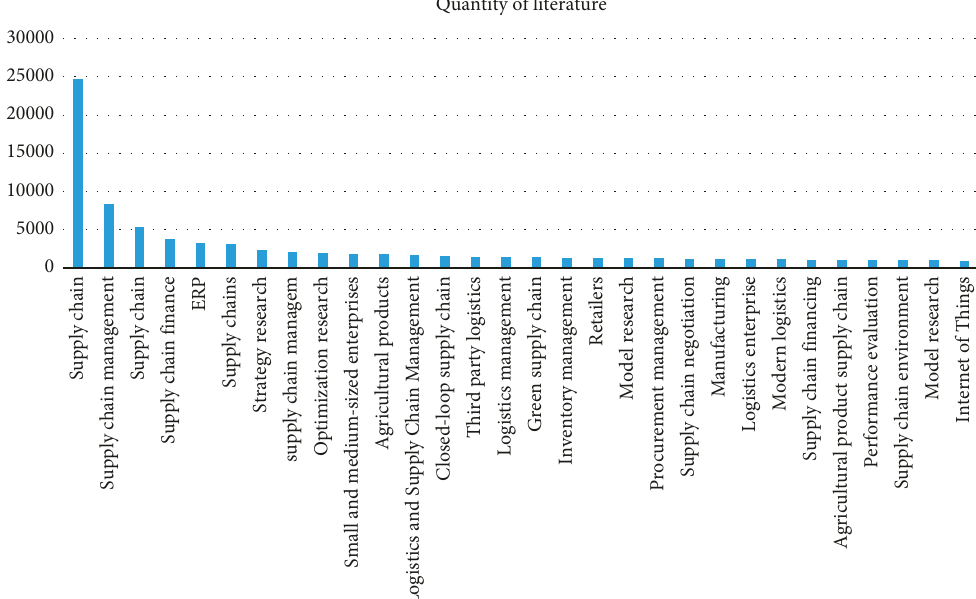
Figure 3: Bar statistical chart of agricultural products